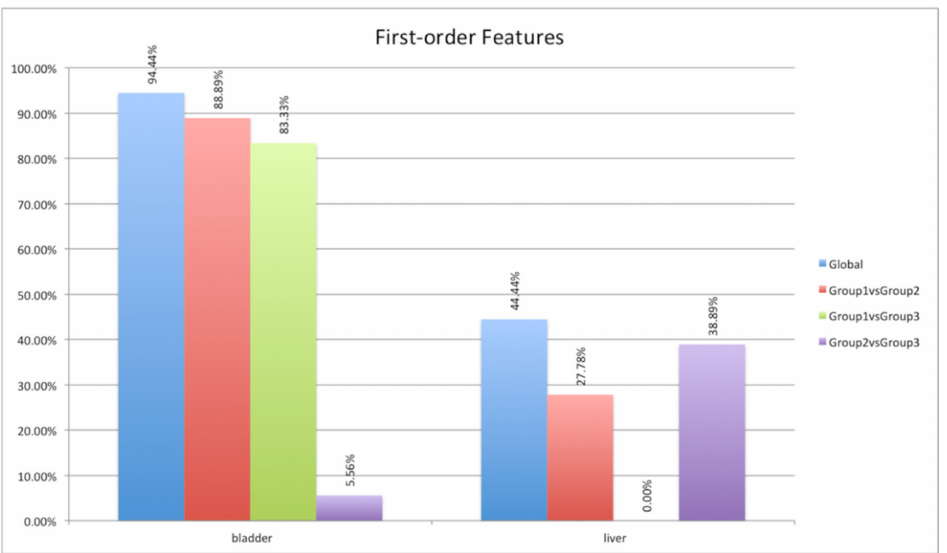
Figure 8. ANOVA and HSD test analyses showing differences in the first-order feature group (18 features) in the three mouse groups (blue column) and differences considering pairs of groups: first group versus second group (red column), first group versus third group (green column), and second group versus third group (violet